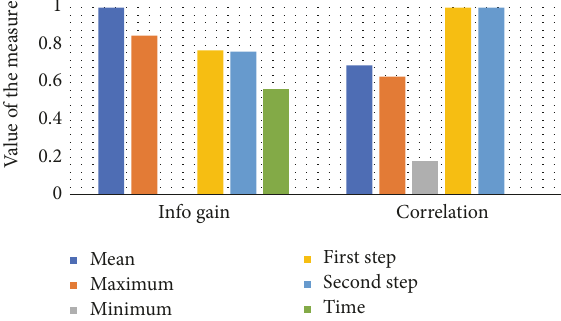
Figure 11: Results of attribute selection with normalized